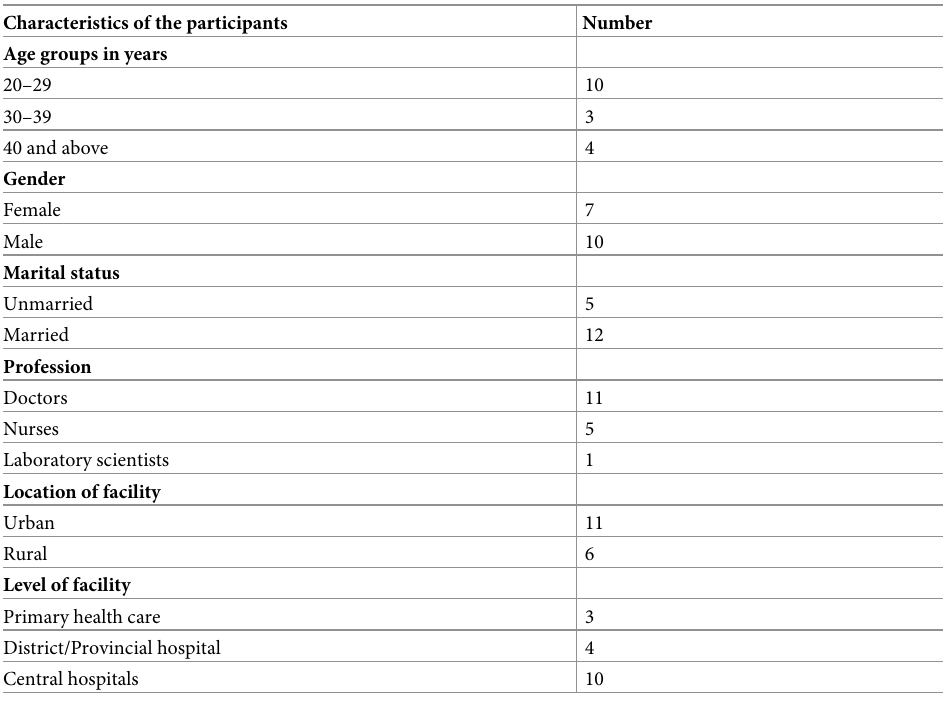
Table 2. Characteristics of the